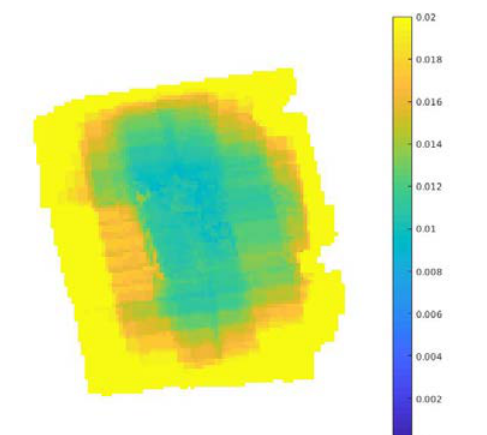
Figure 6. Map of the expected accuracies in z [m] for the nadiral survey.